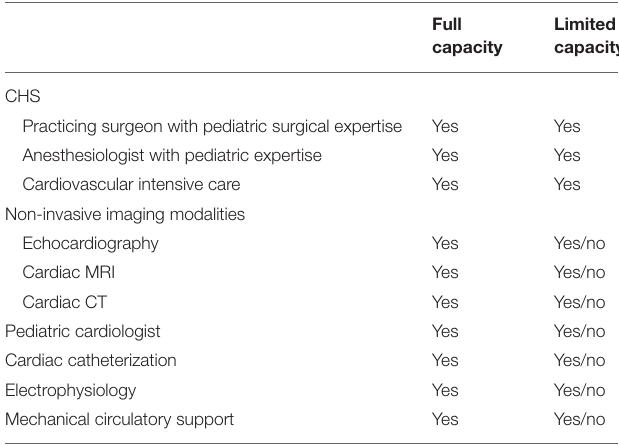
TABLE 1 | Categorization of care facilities for